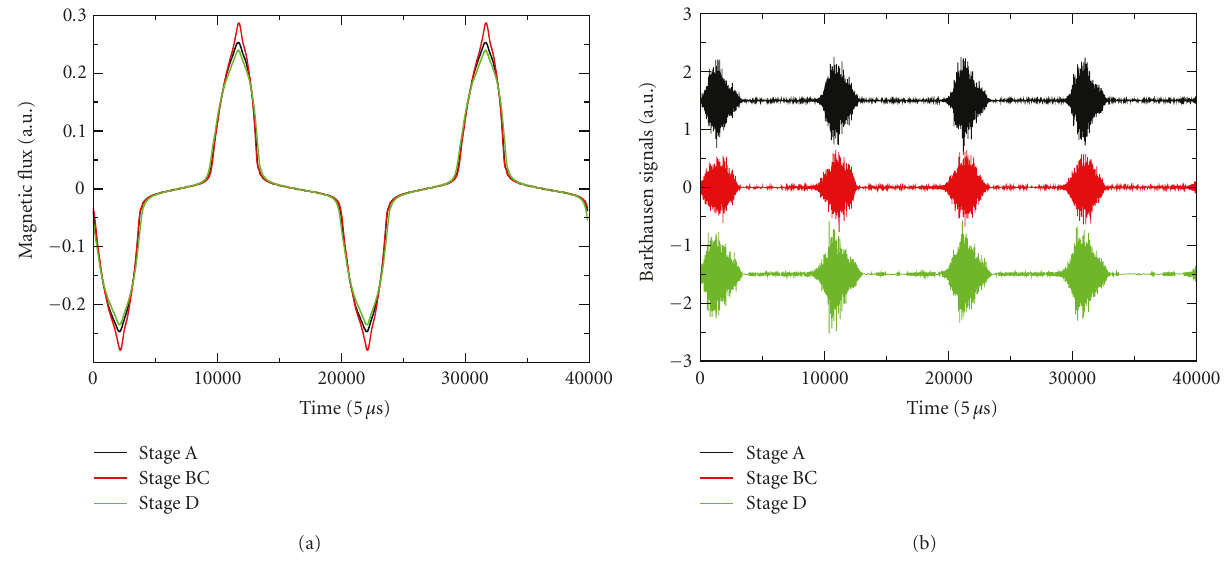
Figure 6: Typical signals of (a) magnetic flux and (b) Barkhausen noise obtained from stainless-steel samples at di ff erent stages of microstructural degradation. Plots in (b) have been vertically shifted for clarity.